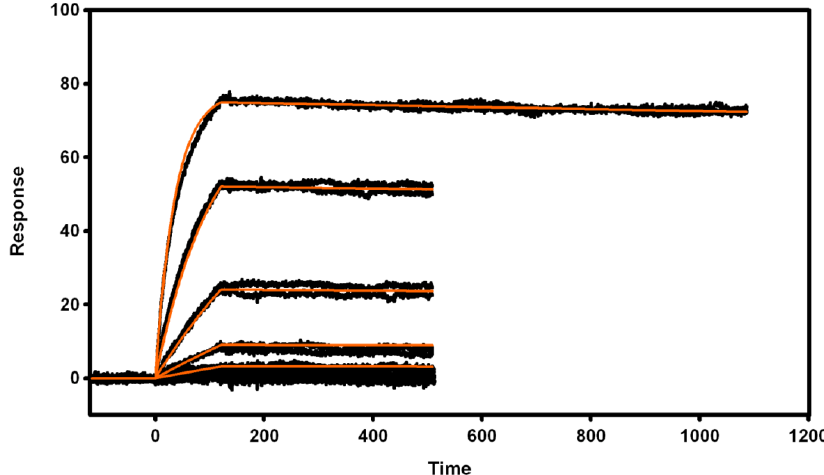
Figure A2. SPR analysis of the interaction between AMA-1 3D7 protein and 1F9 IgG. Approximately 185 RU of 1F9 IgG was captured onto an SPR chip via rabbit anti-mouse IgG at the start of each binding cycle. AMA-1 protein was injected at 50  L/min for 2 min and the dissociation monitored for either 300 s or 900 s. Injected AMA-1 concentrations were 729, 243, 81, 9 and 3 nM. Following dissociation phase, chip surface was regenerated with 10 mM Glycine pH 1.7 resulting in a complete removal of both AMA-1 and 1F9 proteins. Binding data (black lines, in duplicate) were fitted globally with a 1:1 kinetic interaction model (red lines) yielding a k of 3.8 × 10 4 M −1 s −1 , a k of 3.5 × 10 −5 M s −1 and a d an equilibrium dissociation constant ( K ) of 0.95 nM. SensiQ Pioneer instrument docked D with COOH5 chip was utilized for this experiment.